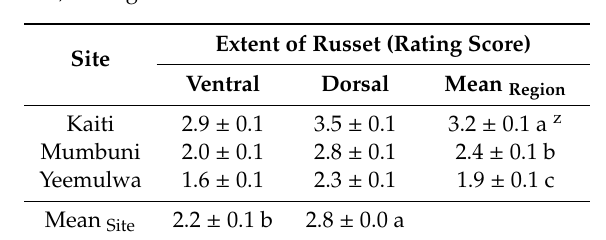
Table 2. Russeting in ventral and dorsal regions of ‘Apple’ mango from three di ff erent sites. The sites were selected because they di ff ered in elevation. Russeting was quantified using a five-score rating scheme. Score 0: 0% of the fruit surface area russeted; score 1: 1–10% russeted area; score 2: 11–25% russeted area; score 3: 26–50% russeted area; and score 4: 51–100% russeted area. For ventral and dorsal regions of the fruit, see Figure 7.